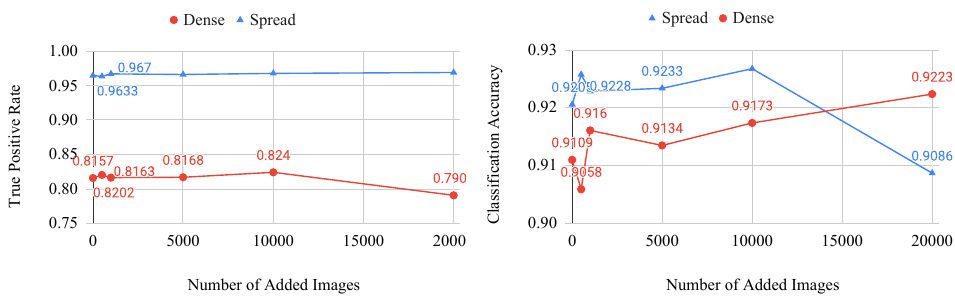
Figure 10. Graphs of classification metric (left: true postitive rate, right: classification accuracy) vs. number of added generated images for the dense and spread classes. These graphs are used to determine the saturation point of a CNN, which is where the generated images no longer provide useful features to the